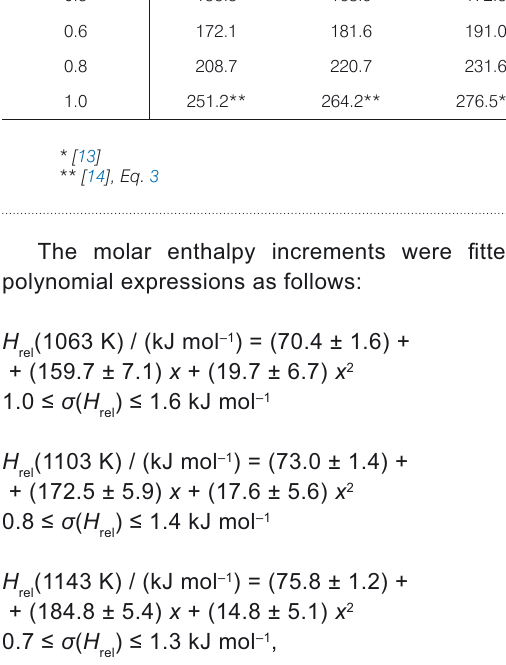
TaF . Curves represent Eqs. 2 7